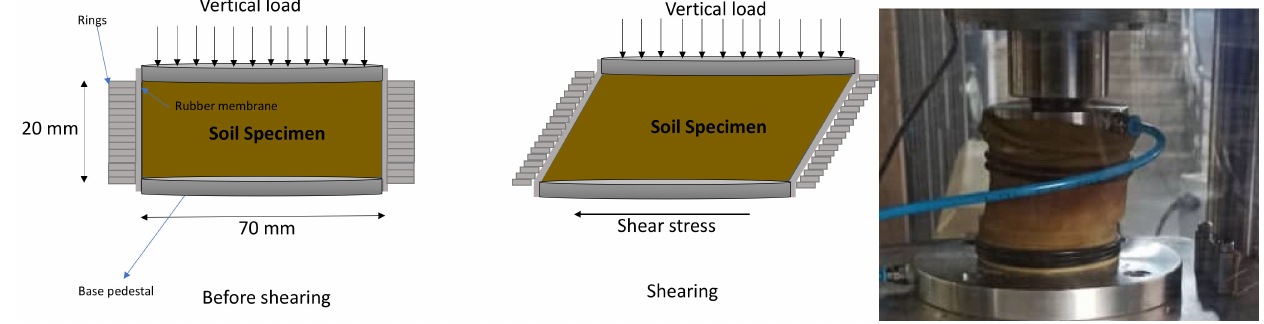
Figure 2. Illustration of the employed dynamic simple shear test